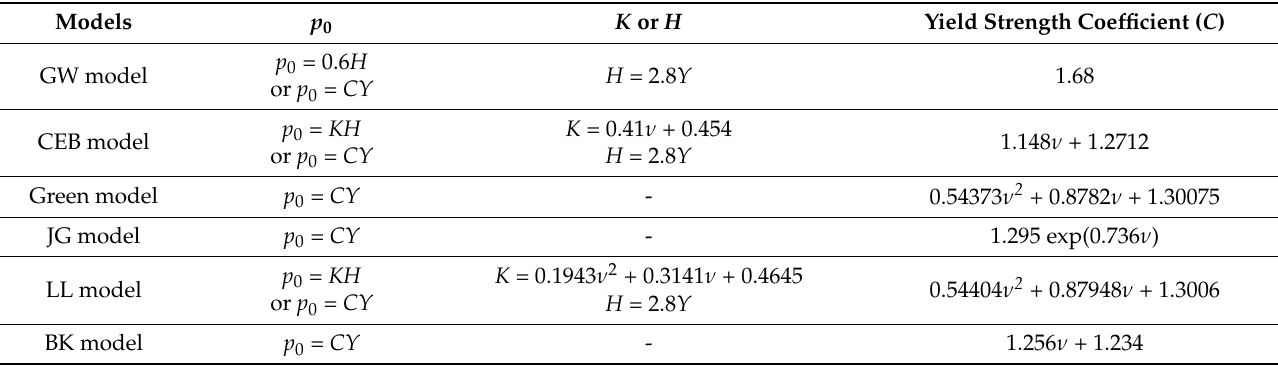
Table 1. Summary of maximum contact pressure ( p 0 ).